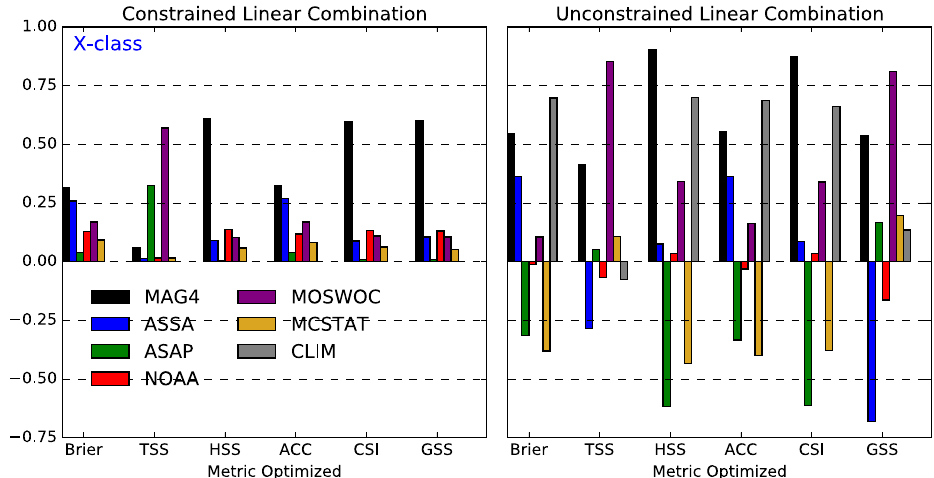
Fig. C.2. Same as Figure 4, but for X-class fl are